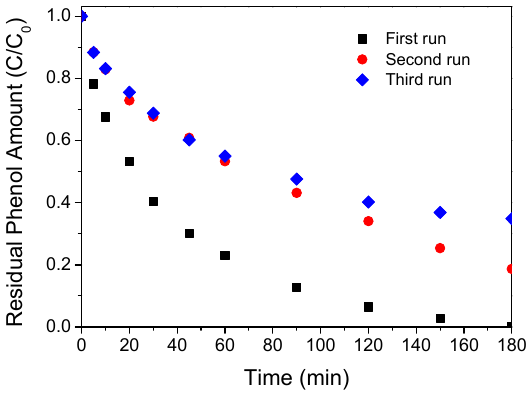
Figure 11. Phenol degradation on Mn/MCS ‐ R at different runs after recycling. Reaction conditions: [phenol] 0 = 20 mg/L, catalyst loading = 0.2 g/L, Oxone loading = 2.0 g/L, and T = 25 °C.